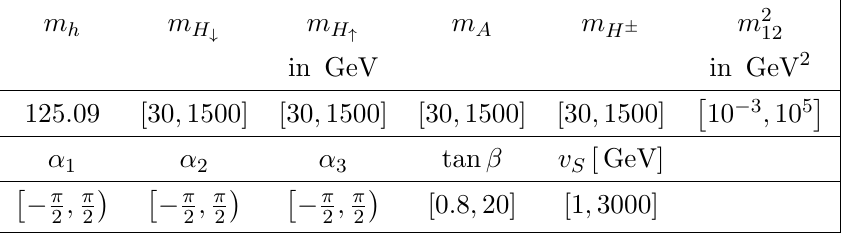
Table 2 . Parameter ranges for the N2HDM T1 input parameters used in ScannerS .